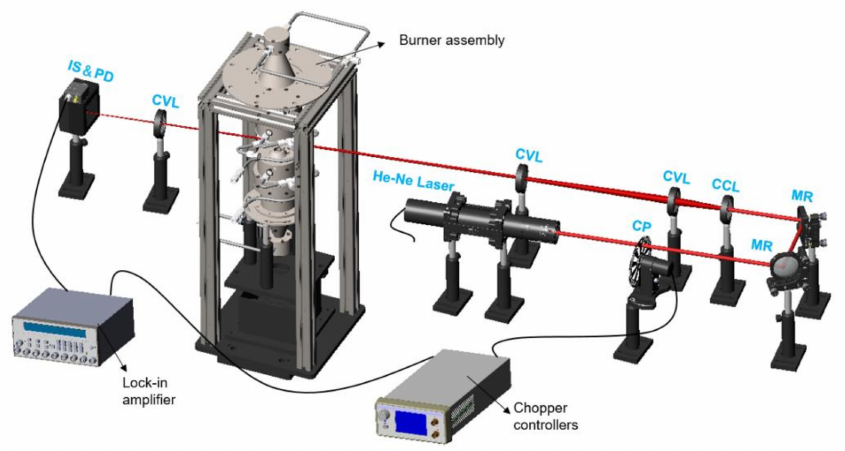
Figure 1. Schematic of the light extinction experimental setup. MR: silver mirror, CP: mechanical chopper, CCL: concave lens, CVL: convex lens, and IS & PD: integrating sphere and